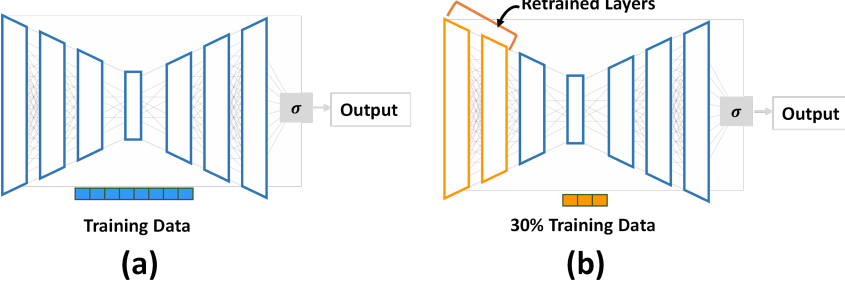
Figure 8. ( a ) Structure of the baseline U-notch DNN developed using U-notch training data. ( b ) The baseline U-notch DNN with the first two layers retrained with 30% of the V-notch training